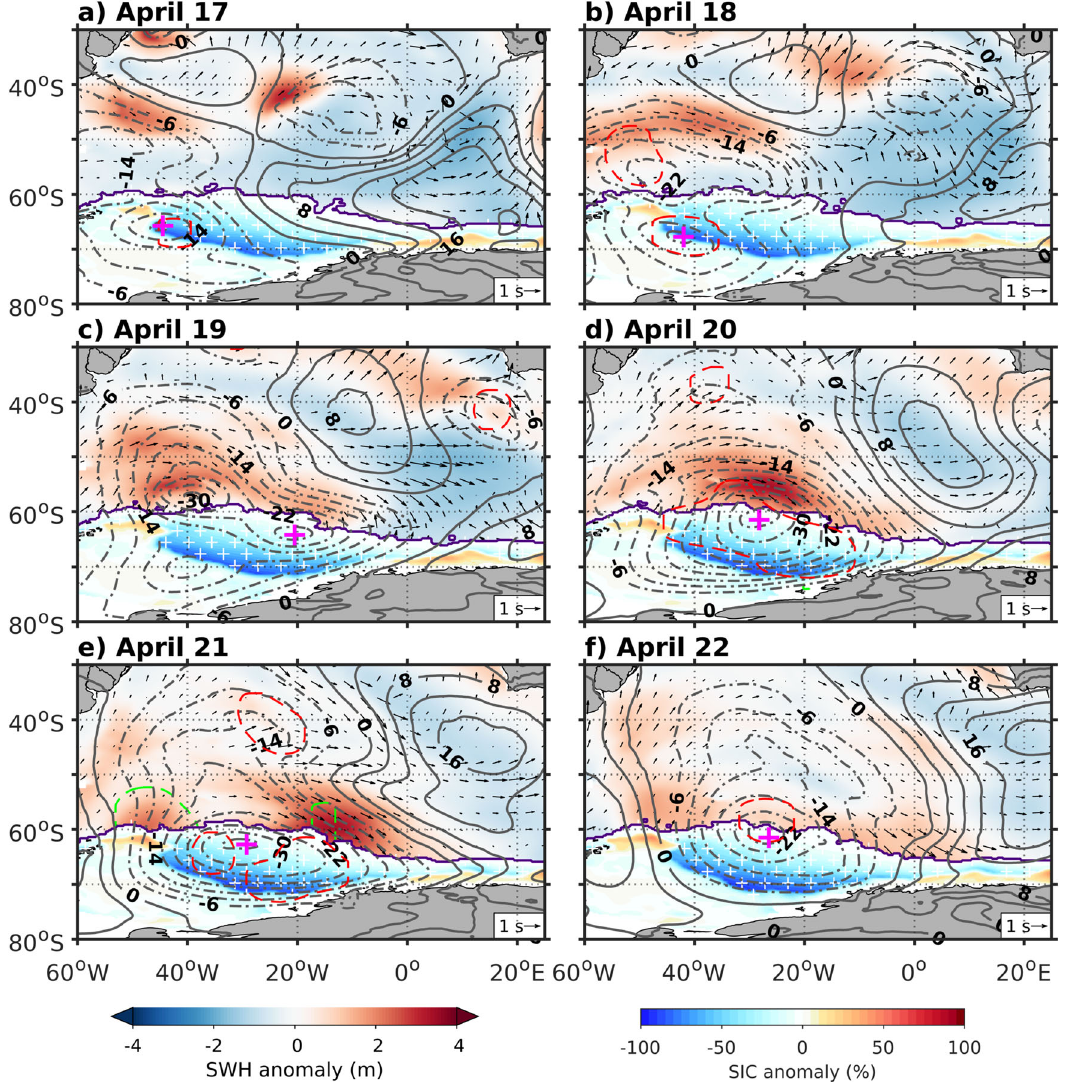
Fig. 6 Ocean waves – sea ice interaction during explosive cyclones. a – f Anomalies in daily signi fi cant wave height (SWH) shown in color- shaded panel to the north of sea ice edge (purple lines), with wave direction and period (black arrows) of combined wind waves and swells, mean sea level pressure (gray contours) are overlaid on anomalous sea ice concentration (SIC, color-shaded panel to the south of sea ice edge) during 17 – 22 April 2019 (Methods section ‘ Ocean waves ’ ). Regions within red (green) dashed polylines have record low (high) values that remain outside from 1979 to 2020. Within this, the record low is shown for MSLP, while the record high is shown for the SWH. The pink plus mark shows the low-pressure centre of the cyclone. The anomalies are computed relative to the climatology of 1979 –